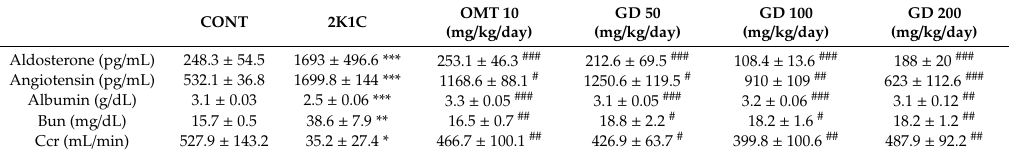
Table 2. E ff ects of the Gynura divaricata (L.) DC (GD) treatment on renal functional parameters.